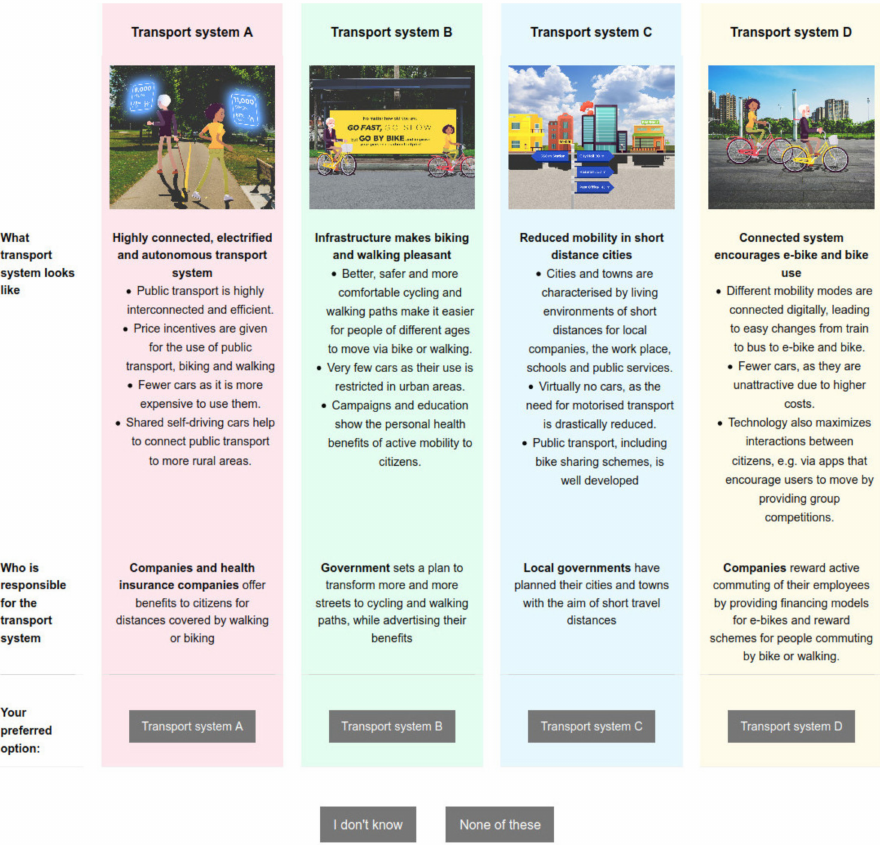
Figure A2. Example of a choice card—INHERIT scenarios, Active mobility domain (Transport system A corresponds to the “My life between realities” scenario, Transport system B to the “Less is more to me” scenario, Transport system C to the “One for all, all for one” scenario, and Transport system D to the “Our circular community”